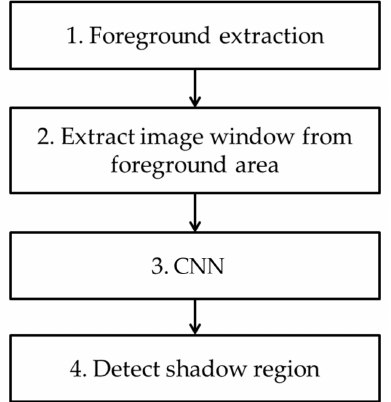
Figure 1. Overall flowchart of proposed